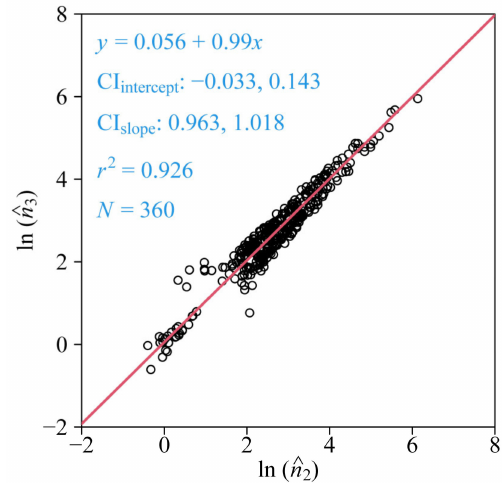
Figure 4. Fitted results to the data of the estimated values of the model parameter n 3 vs. the model parameter n 2 (Equation (3)). The data were fitted according to reduced major axis protocols on a log-log scale. y represents the ln-transformation of the estimated value of n 3 ; x represents the ln-transformation of the estimated value of n 2 ; the straight line is the regression line; CI intercept represents the 95% confidence interval of the intercept; CI slope represents the 95% confidence interval of the slope; r 2 is the coefficient of determination that reflects the goodness of fit; and N is the sample size, i.e., the number of flowers